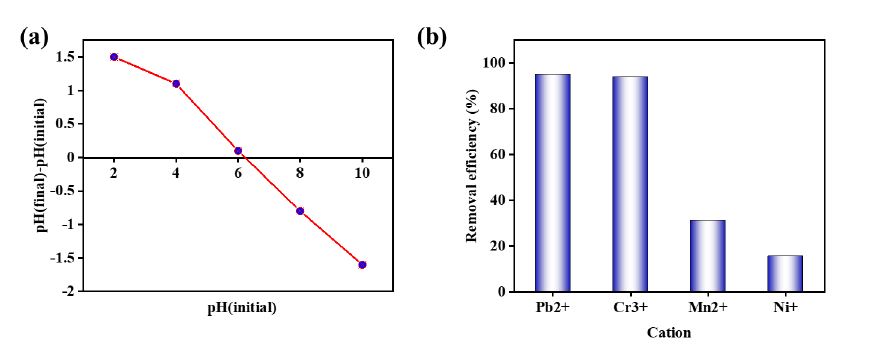
Figure 8. (a) pH zpc zero-point charge of magnetic oxide NPs, (b) Effect of the presence of other metal ions on the removal of lead (II) by Fe 3 O